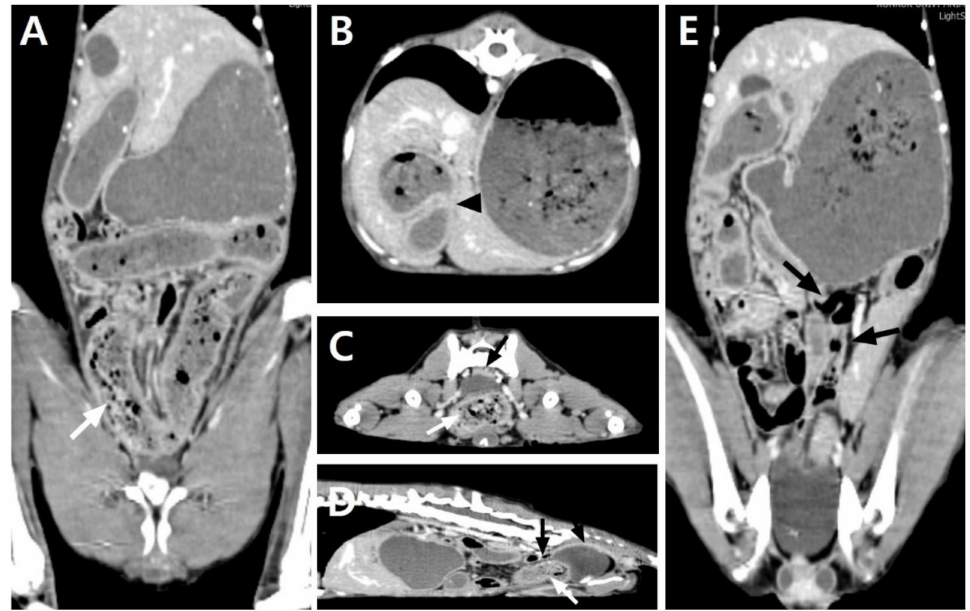
Figure 1. Postcontrast dorsal ( A , E ), transverse ( B , C ), and sagittal ( D ) computed tomography images of the abdomen of the dog with severe dilatation of the overall small intestines. The stomach and overall jejuna are markedly dilatated, and the proximal jejuna are plicated at an acute angle, causing a stenotic lumen ( B , black arrowhead). The small-bowel fecal signs show hyper-attenuated fecal-like materials mixed with gas bubbles from the dilated jejunal segments to the entire ileum ( A , C , D , white arrows). The large intestines from the ileocecocolic junction to the rectum are collapsed, with little gas and no fecal contents ( C – E , black